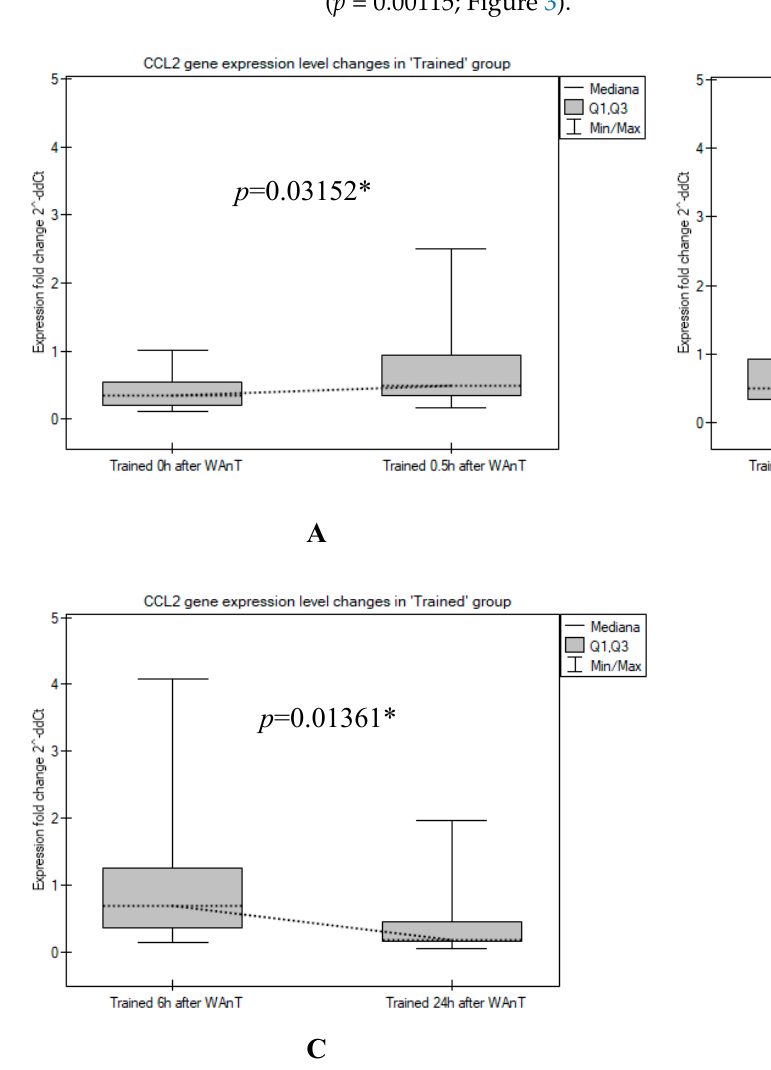
Figure 2. A comparison between the CCL2 gene expression levels measured in the “Trained” group in post-tests: ( A ) 0 h vs. 0.5 h after WAnT; ( B ) 0.5 h vs. 6 h after WAnT; and ( C ) 6 h vs. 24 h after WAnT. ( p values are Mann–Whitney U-test asymptotic p values corrected for ties, * statistically significant differences).